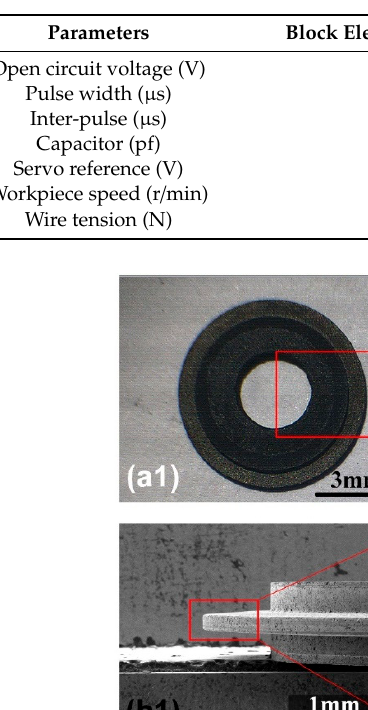
Table 1. Block electrode EDM grinding/micro-WEDM parameters.